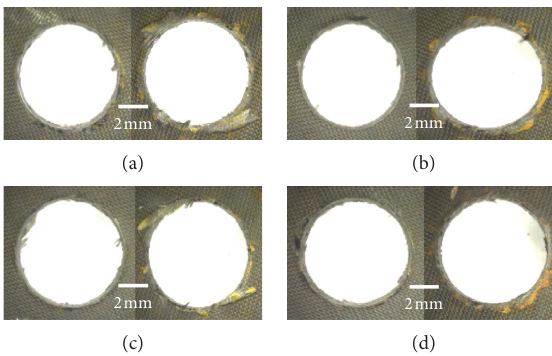
Figure 8: The shape of blade-grinded drills.